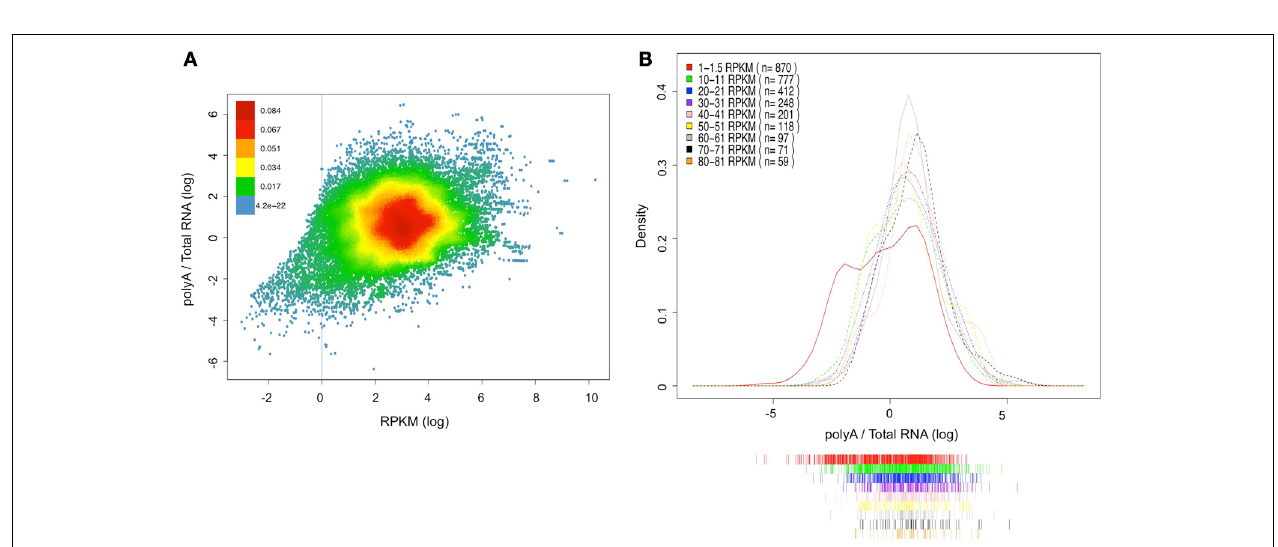
values. All transcripts were ranked according to their intron/exon RPKM ratio. The rank values of the top or bottom 5% PA/TR were extracted and plotted.